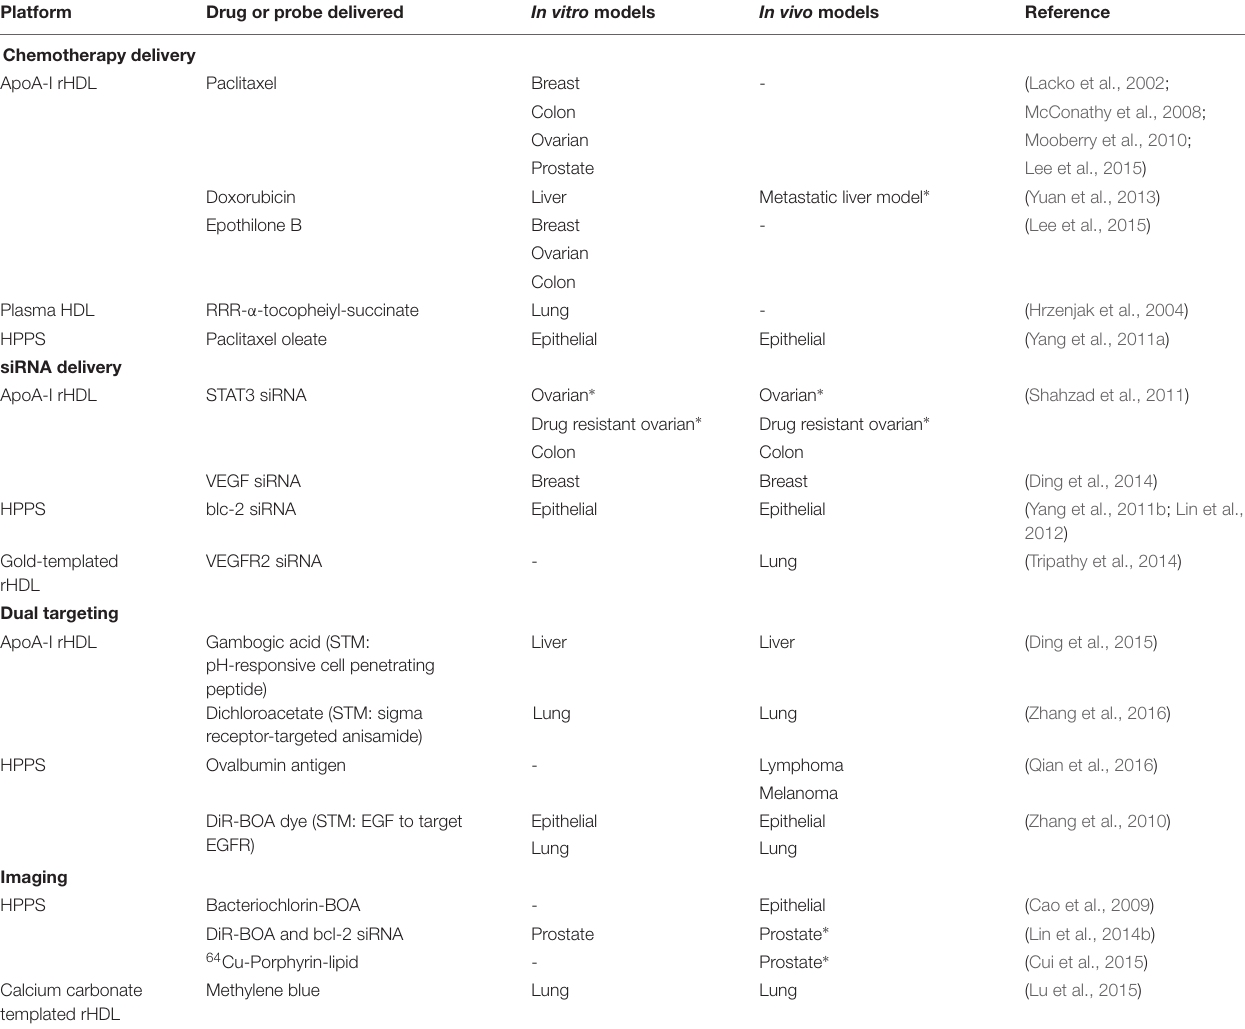
TABLE 2 | Examples of SR-BI-targeted drug and imaging probe delivery vehicles applied to in vitro and in vivo cancer models.